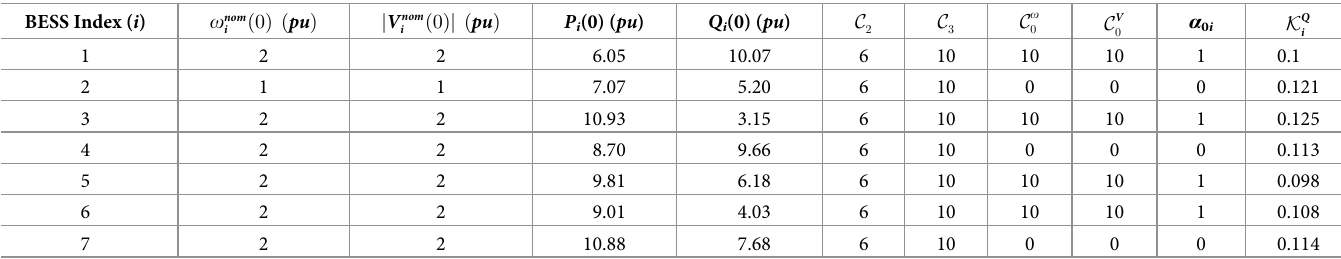
Table 2. Different parameters of the BESSs for proportional active and reactive power sharing, and frequency and voltage regulation. BESS Index ( i